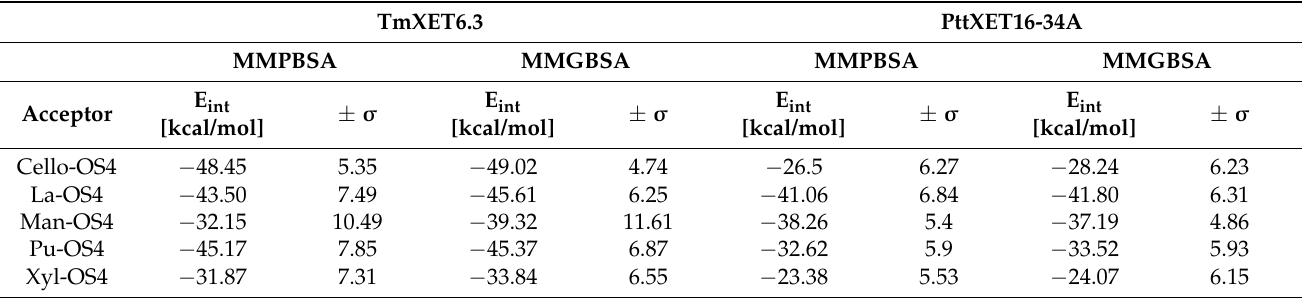
Table 5. Binding free energy values of TmXET6.3 and PttXET16A in complex with linear acceptors based on MM(PB/GB)SA calculations. Values were obtained from 800–1000 ns time intervals of MD